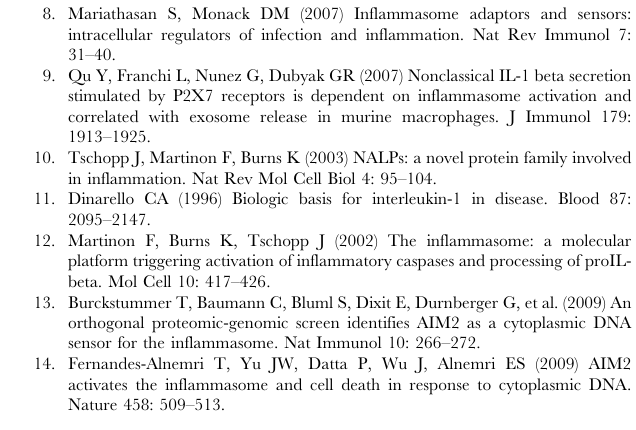
Figure S2 WT-WT chimera mice exhibit similar infec- tion levels to WT non-irradiated WT controls. Fungal burdens were determined (A) tongue and (B) kidneys. (C) Gross Clinical score was used as a measure of disease severity. Table S1 Primers used for measurement of gene up- regulation by real-time PCR. List of forward and reverse gene specific primers, and PCR product size, used in quantitative real- time